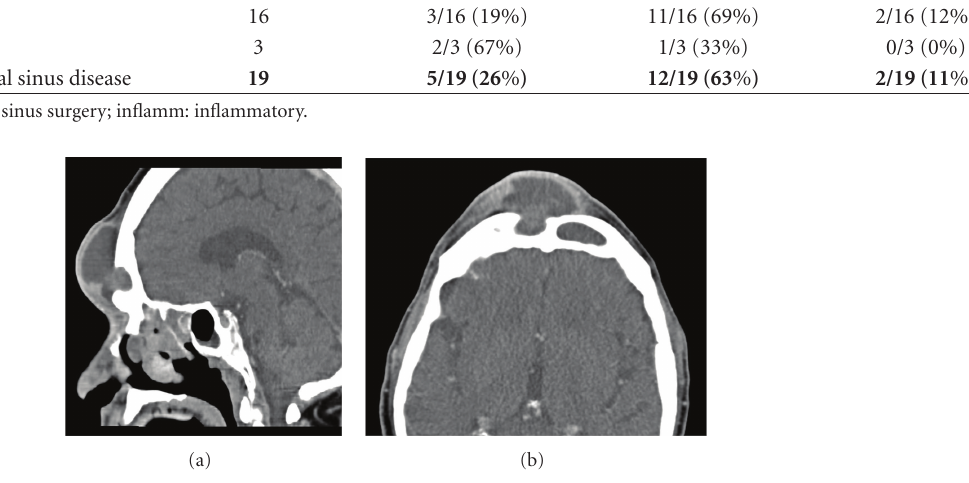
Table 2: The majority of salvage osteoplastic frontal sinus obliteration (OFSO) patients failed prior endoscopic frontal sinus surgery. Diagnosis